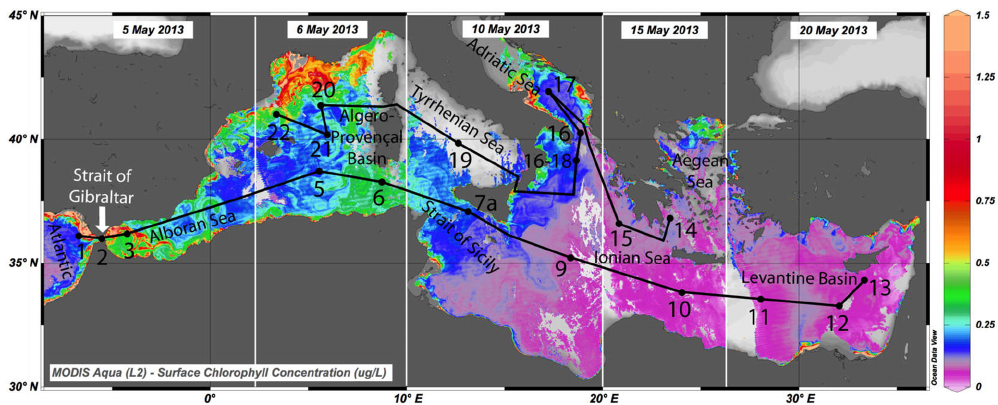
Figure 2. Sampled stations with BONGO nets (dots). The numbers in the picture represent the station codes: first transect – 1 to 13, second transect – 14 to 22. For station code names see Table 1. Color scale at right represents the values of surface chlorophyll concentration (in µgL − 1 ), retrieved from MODIS Aqua (L2) , from the closest day as possible of the first transect, specified in the upper